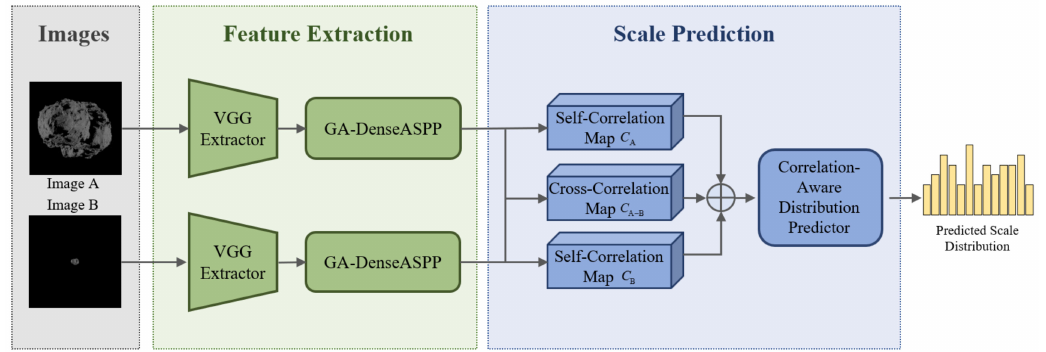
Figure 3. DeepSpace-ScaleNet